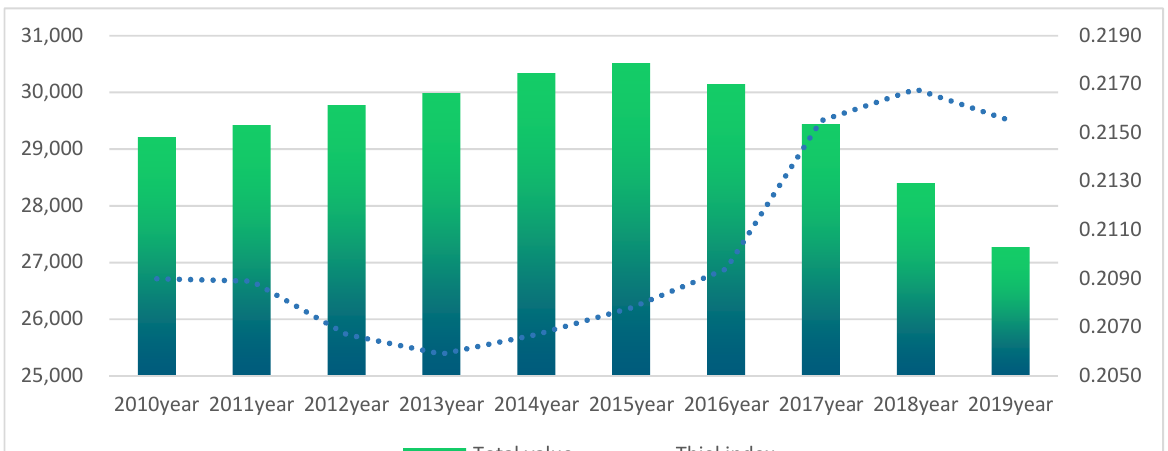
Figure 2. The total value of agricultural carbon emissions in China and the regional Theil index from 2010 to 2019.